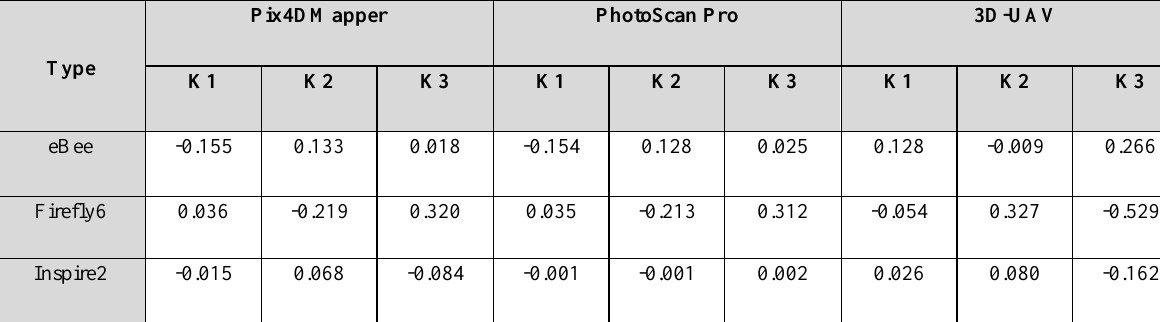
Table 2. The calculated radial distortion coefficients in each